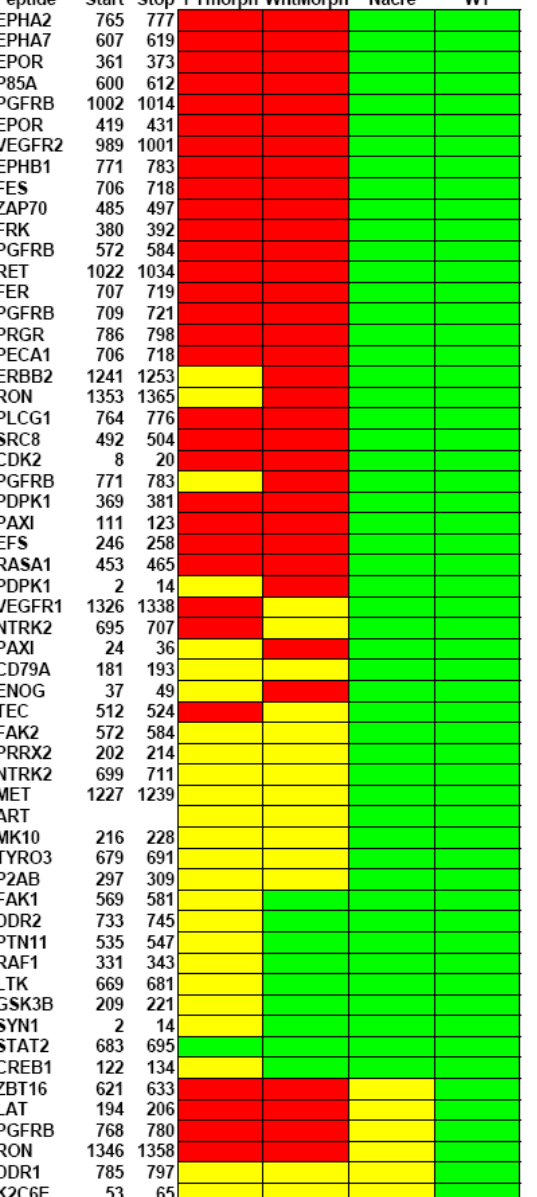
Table S1 The positions of the peptides on the chip are indicated as well as their protein names, the amino acid residue numbers and the sequences of the peptides. Fluorescence intensities for all peptides were determined quantitatively and expressed as arbitrary units. Relative intensities were calculated within in- dividual peptide chips to allow for comparison between different experiments. Averages of two independent experiments were determined and are expressed here as relative signal compared to the signal in wild type, non-injected control embryos (set to 100%). Absolute levels of fluorescence are indicated for wild type, non- injected control (arbitrary units). Signals below the detection threshold level are indicated by a -. The fluorescence intensities of the PTK activity profiles of purified Fyn and Yes are depicted in arbitrary units. Found at: doi:10.1371/journal.pone.0000581.s001 (0.05 MB XLS)